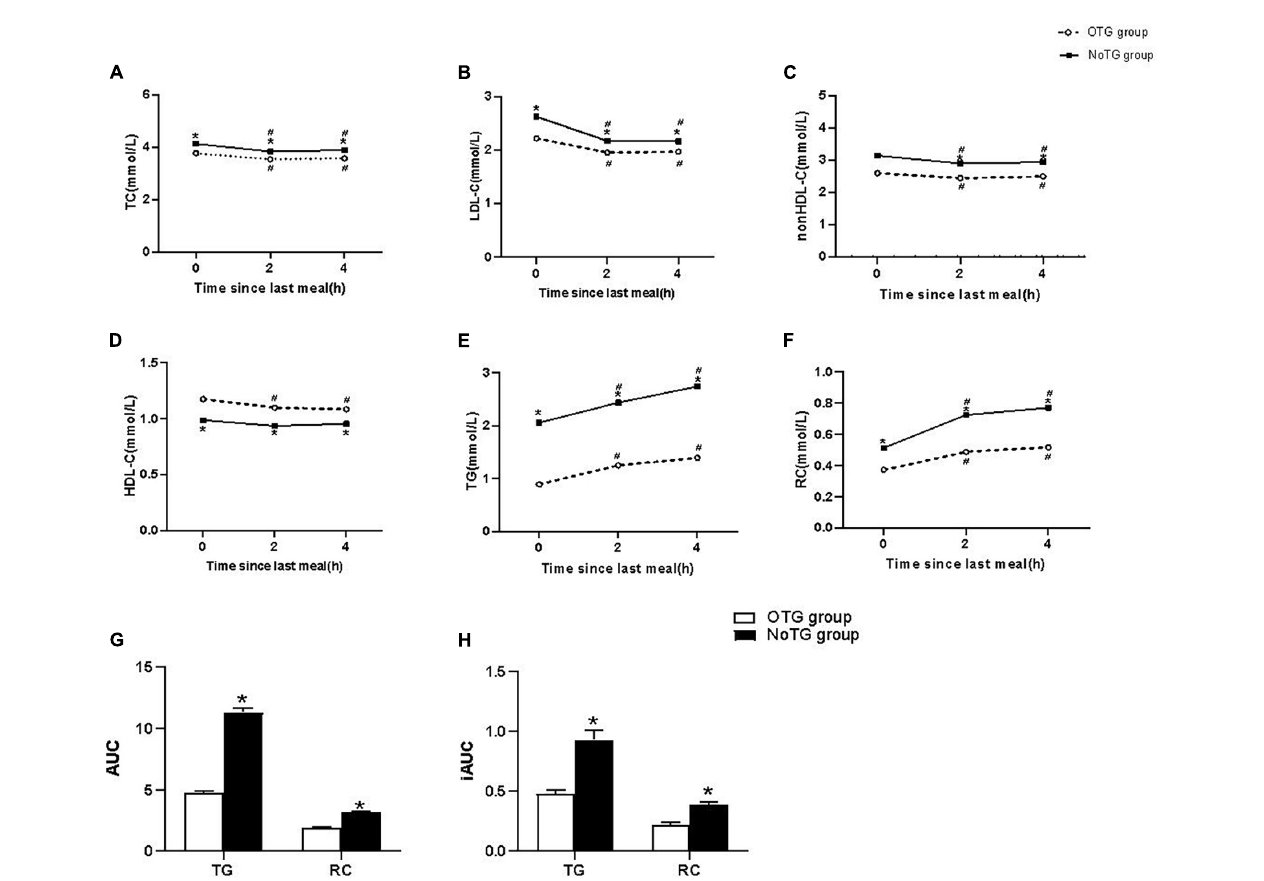
FIGURE1 Postprandial changes in blood lipids after a daily meal in two groups. (A,B,D,E) The changes in serum concentrations of total cholesterol (TC), low-density lipoprotein cholesterol (LDL-C), high-density lipoprotein cholesterol (HDL-C), and triglyceride (TG). (C,F) The changes in serum concentrations of non-HDL-C and remnant cholesterol (RC) were determined by calculated methods. (G) Comparison of the total area under the curve (AUC) for TG and RC between two groups. (H) Comparison of increase in AUC (iAUC) for TG and RC between two groups. Optimal triglyceride (OTG) group: fasting TG < 1.2 mmol/L. Non-optimal triglyceride (NoTG) group: fasting TG ≥ 1.2 mmol/L. Values are mean ± standard error (SE). One-way analysis of variance (ANOVA) for repeated measures within a group or ANOVA for completely randomized measures between groups was used to assess any differences between the means of the variables, as appropriate. * P < 0.05 when compared with the patients in the OTG group. # P < 0.05 when compared with the fasting level in the same group.